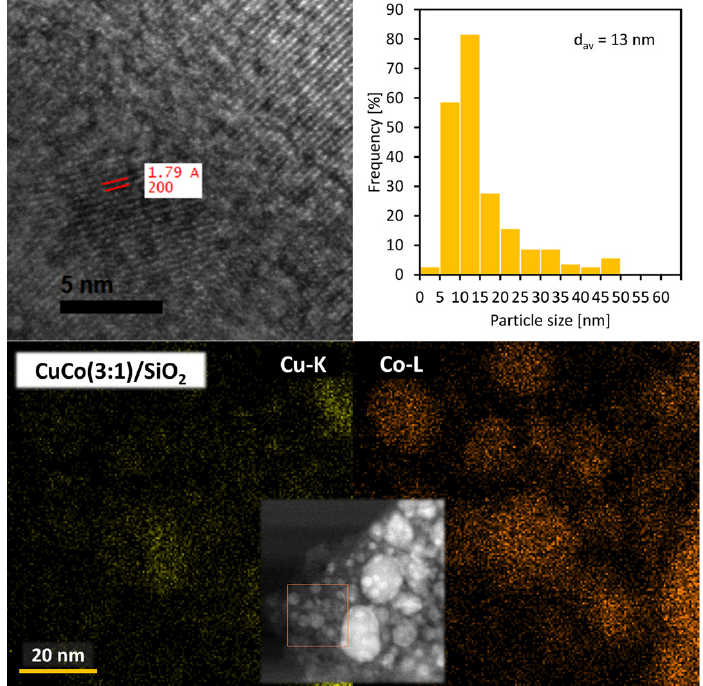
Figure 4. Interplanar distance , TEM mapping and particle size distribution of CuCo(3:1)/SiO 2 .